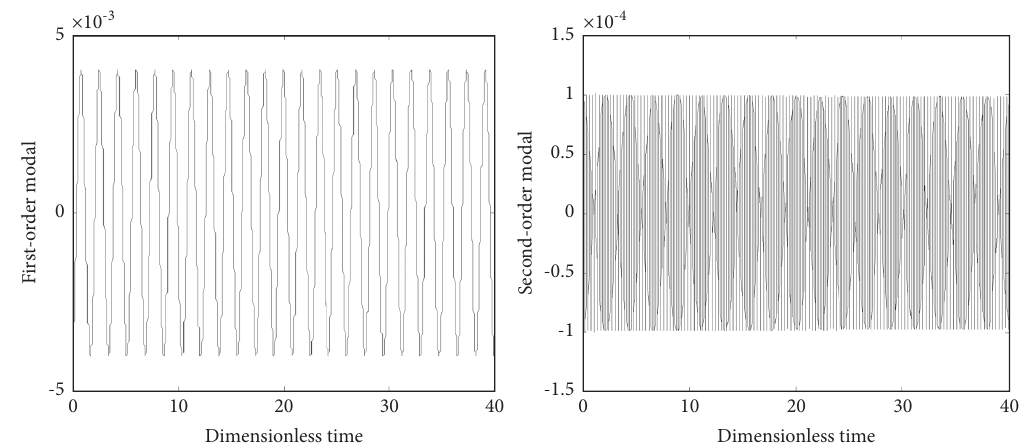
Figure 2: The response of the first two modes of the beam before variable structure control.